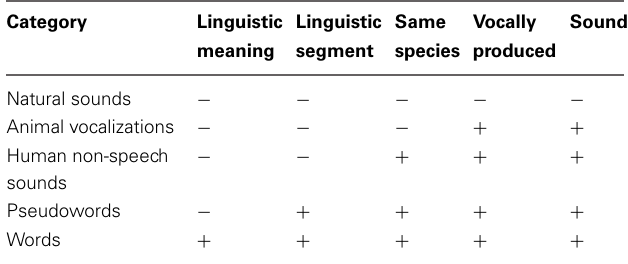
Table 1 | Classification of auditory